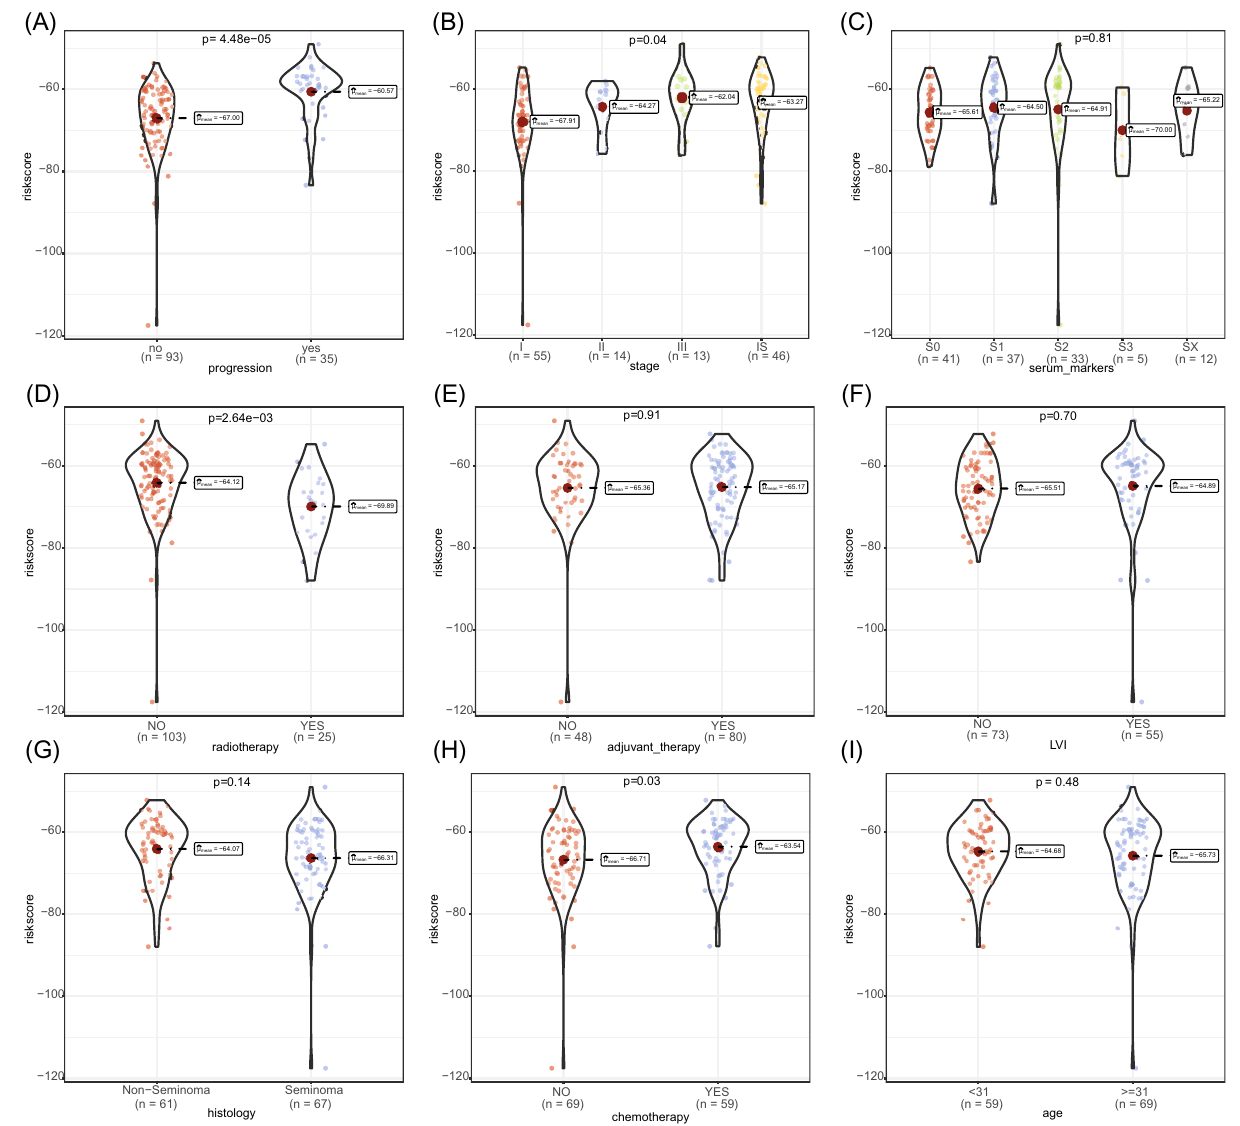
Figure 4. Distributions of the risk score in different clinicopathological groups, including ( A ) survival status, ( B ) stage, ( C ) serum markers, ( D ) radiotherapy, ( E ) adjuvant therapy, ( F ) lymphatic vascular infiltration (LVI), ( G ) histology, ( H ) chemotherapy, and ( I )